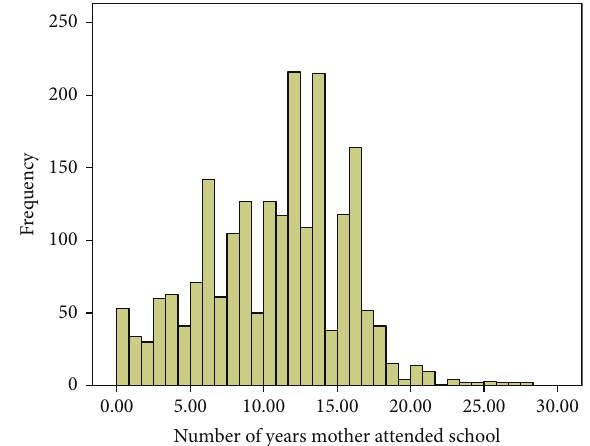
Figure 1: Histogram of the number of missing observations in 75 items used from the NLAAS data.